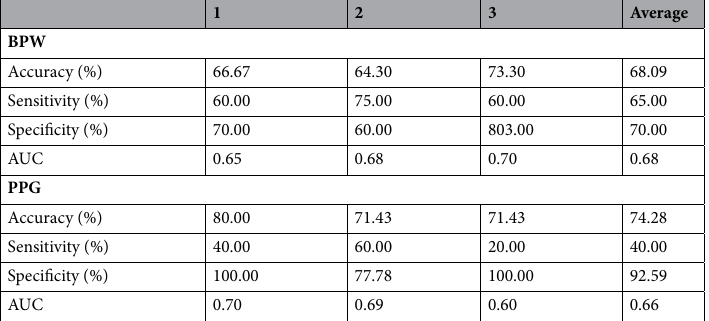
Table 4. MLP analysis results for comparisons of BPW and PPG indices between patients with mild and severe AD. Training and validation results are presented for the threefold cross-validation. For BPW indices, there were 941 and 913 pulses for severe and mild AD, respectively. For PPG indices, there were 637 and 634 pulses for severe and moderate AD,